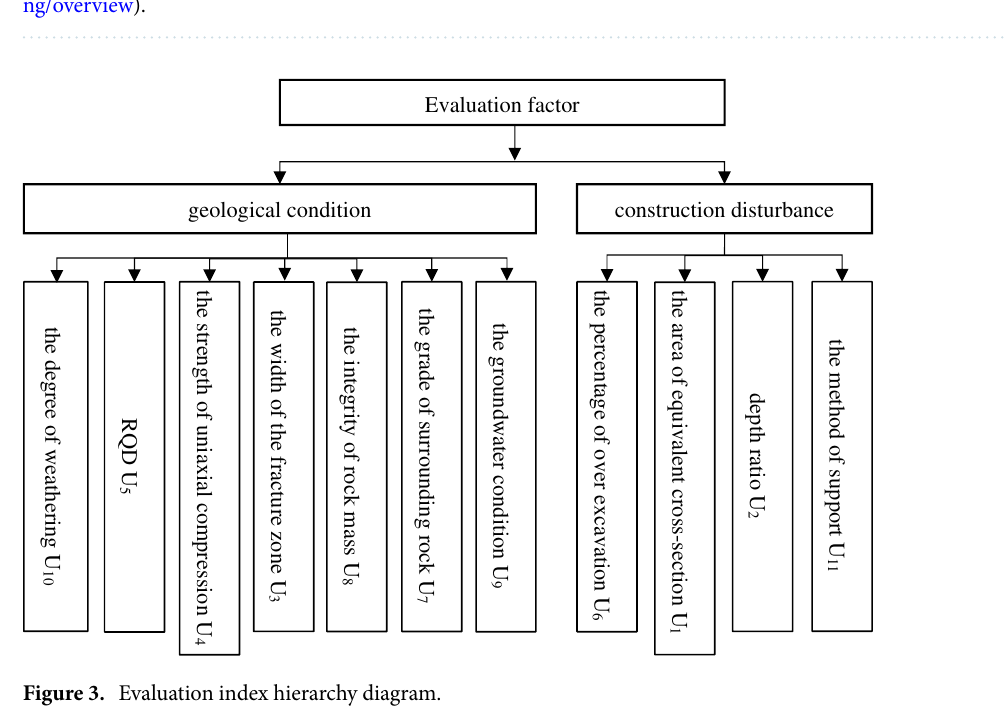
Figure 2. Location of the Ka-Shuang Tunnel (Arcgis10.8 https:// www. esri. com/ en- us/ arcgis/ produ cts/ mappi ng/ overv iew).